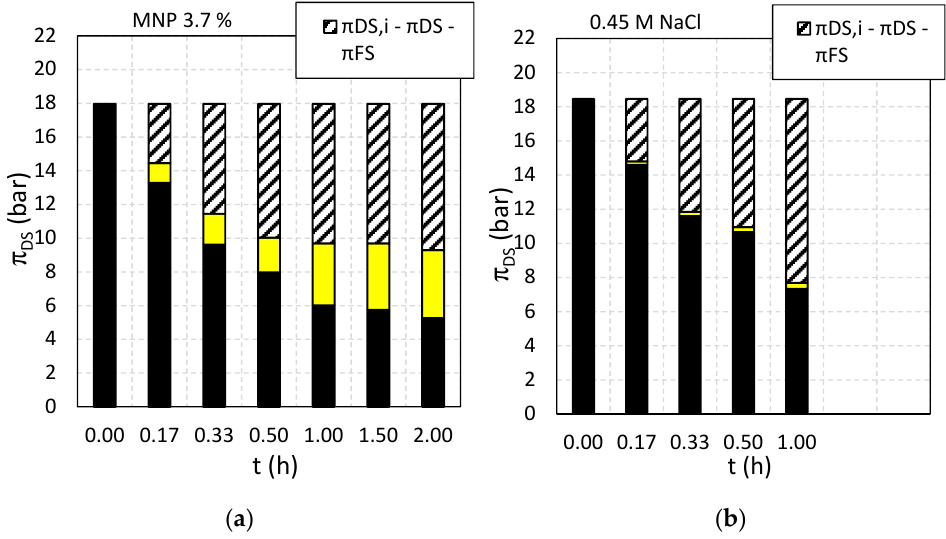
Figure 12. Osmotic pressures when DS is ( a ) Fe 3 O 4 @CA and ( b ) 0.45 M NaCl, during the time. Black columns present the osmotic pressure in the DS during filtration, which is decreasing because of two factors: (i) outcoming salts from DS to FS (yellow part of columns) and (ii) incoming water from the FS that is diluting DS (hatched part of columns).